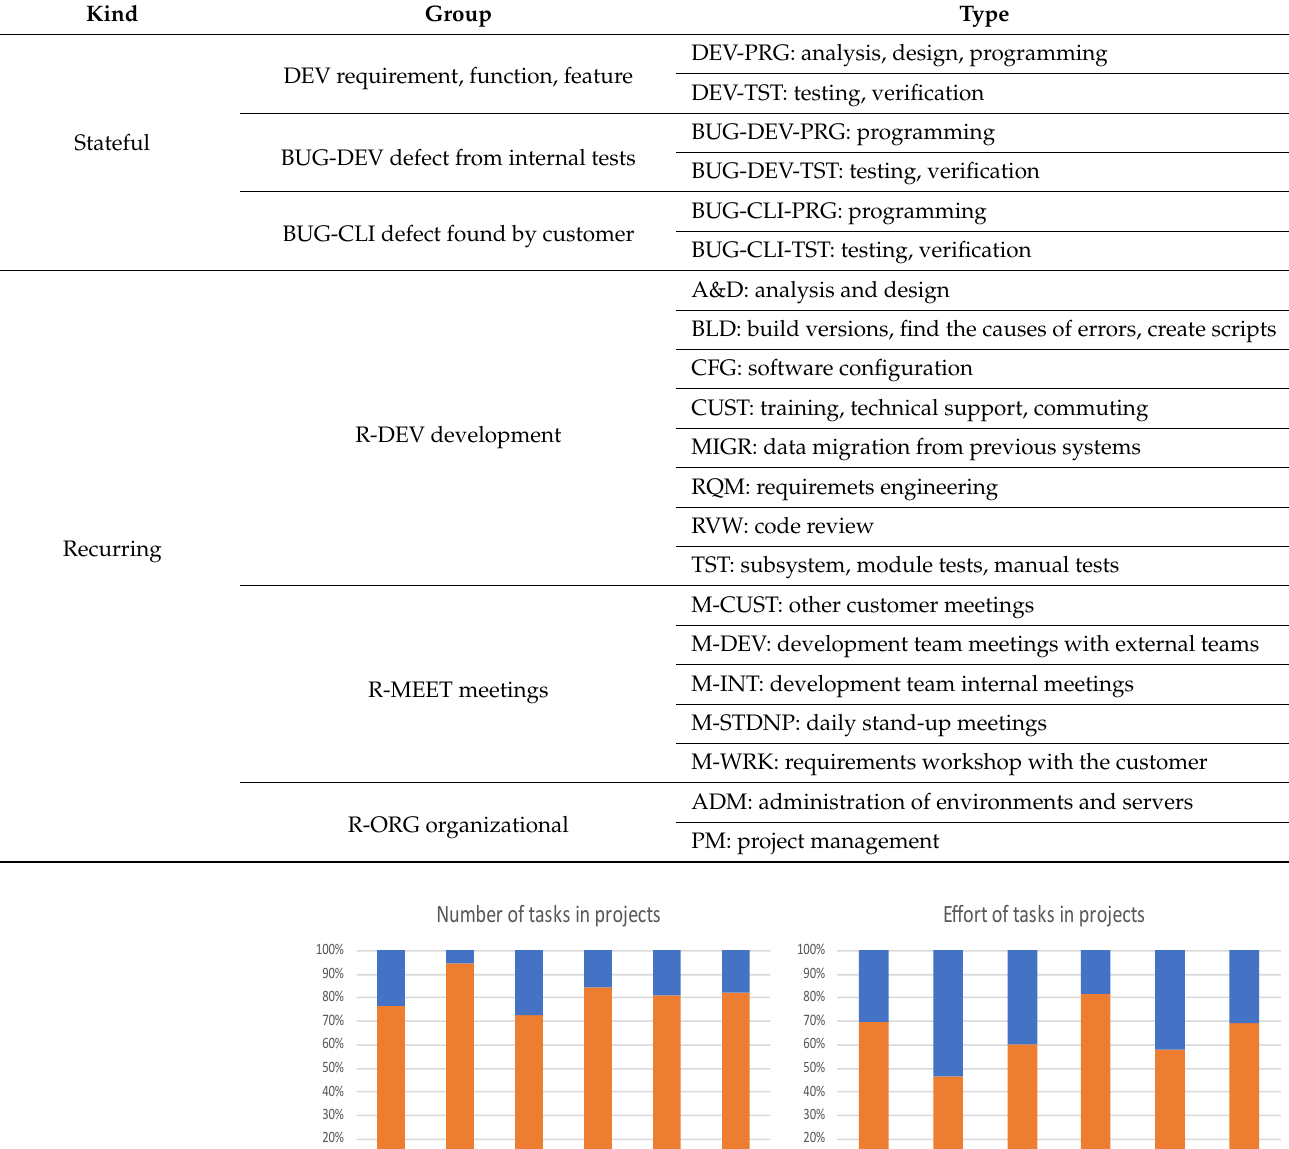
Table 2. Types of stateful and recurring tasks used by the model.